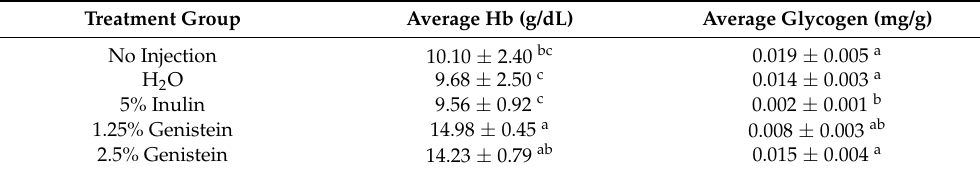
Table 3. Blood hemoglobin (Hb) concentrations (g/dL) and pectoral muscle glycogen concentrations (mg/g) following genistein exposure 1 .